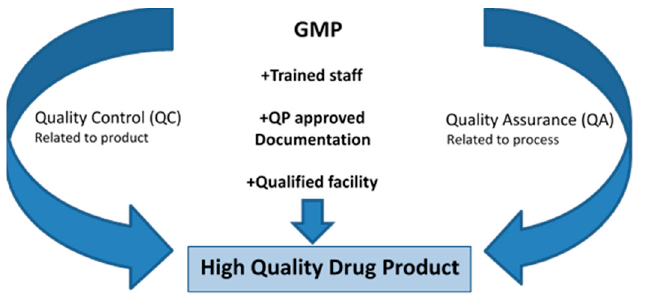
Figure 6. Validation of drug product.